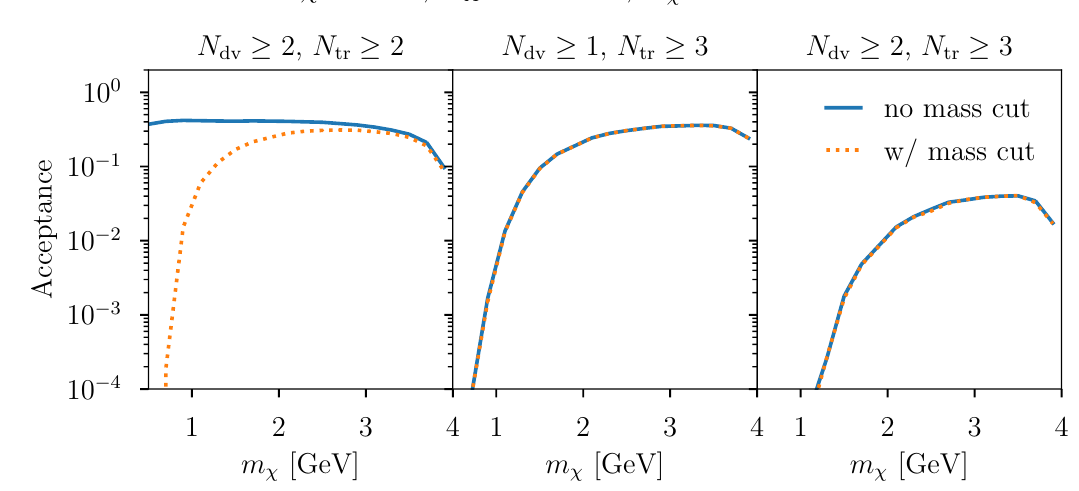
Figure 13 . Comparison of signal acceptance with and without a vertex track-mass cut > 0 . 5 GeV to reduce kaon